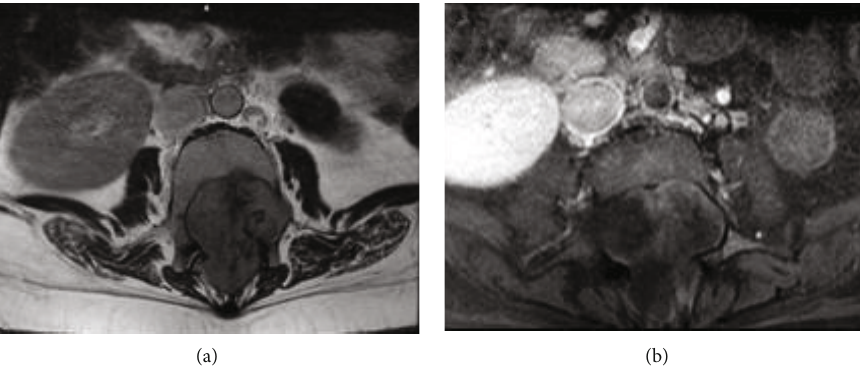
Figure 2: A lumbar spine MRI axial view ((a) T2 and (b) T1 with